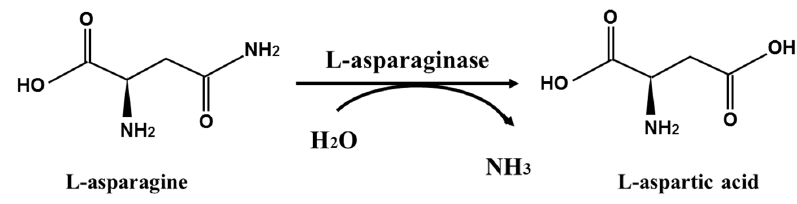
Figure 1. The molecular reaction scheme of L ‐ asparaginase.